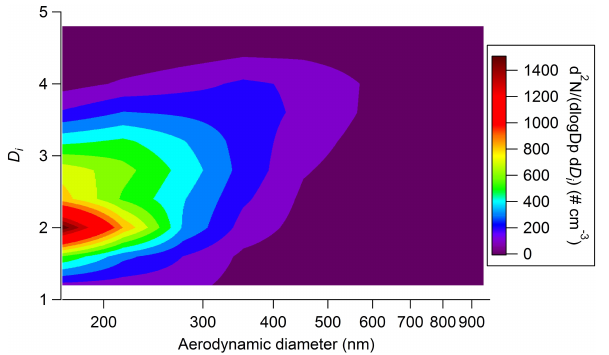
Figure 1. Campaign-averaged dependence of particle number con- centration on ATOFMS-derived BC mass fraction and particle di- ameter.